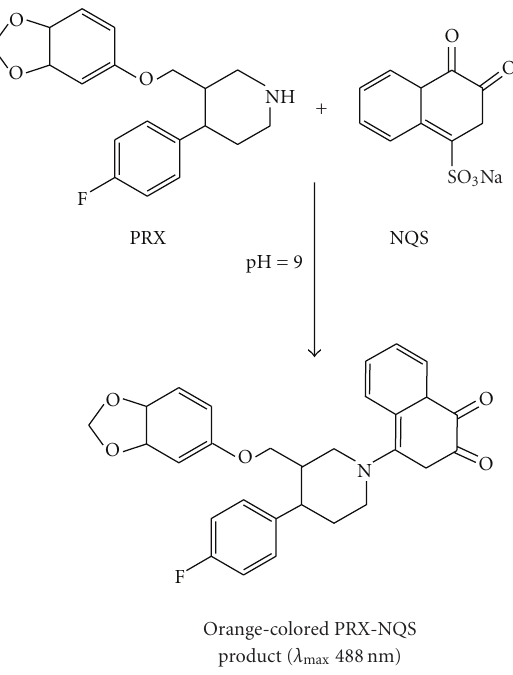
Figure 7: Scheme for the reaction pathway of PRX with NQS.